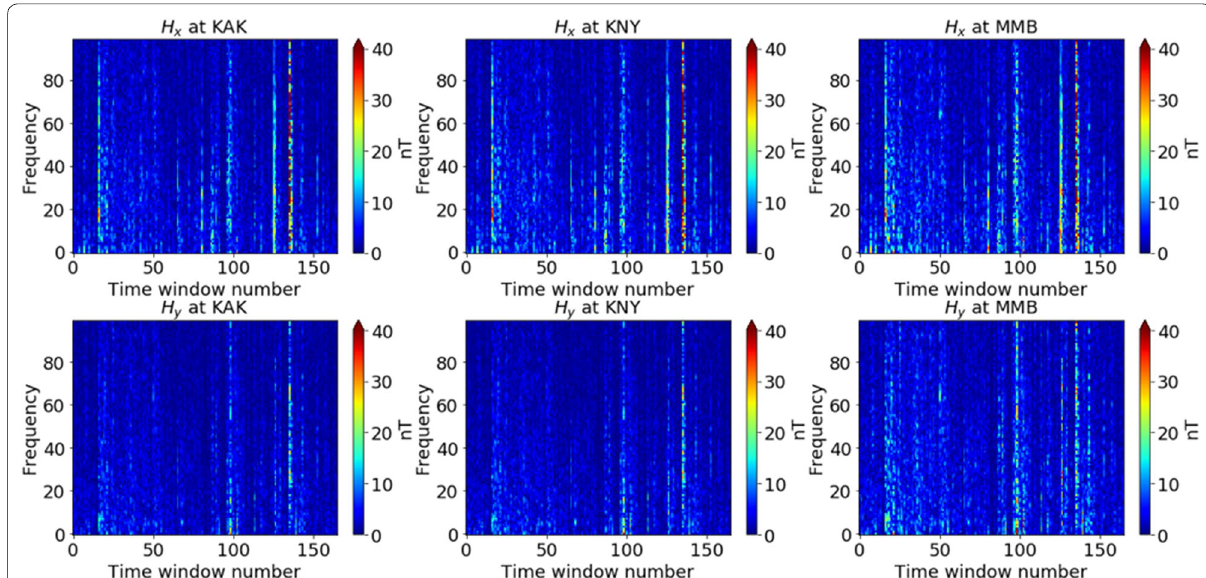
Fig. 3 Amplitudes of spectrograms of geomagnetic data with x (upper) and y (lower) direction, acquired at KAK (left), at KNY (middle), and at MMB (right). The vertical axis denotes the frequencies between 9/30,720 Hz and 108/30,720 Hz, and the standard is 9/30,720 Hz (i.e., the value 0 in the vertical axis corresponds to 9/30,720 Hz). The horizontal axis denotes time window number, with a total of